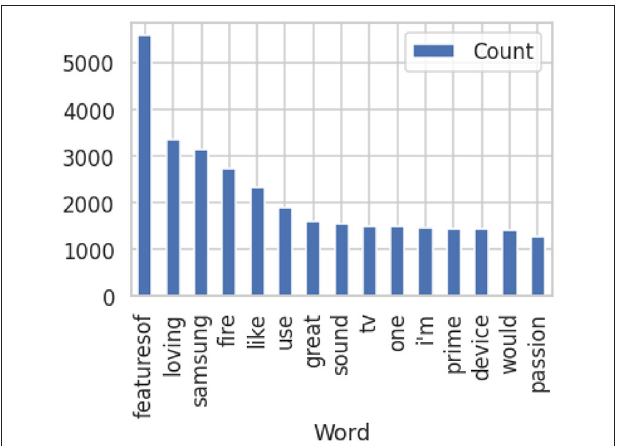
FIGURE 5 | Prominent words in data set after pre-processing tweets with NLP.